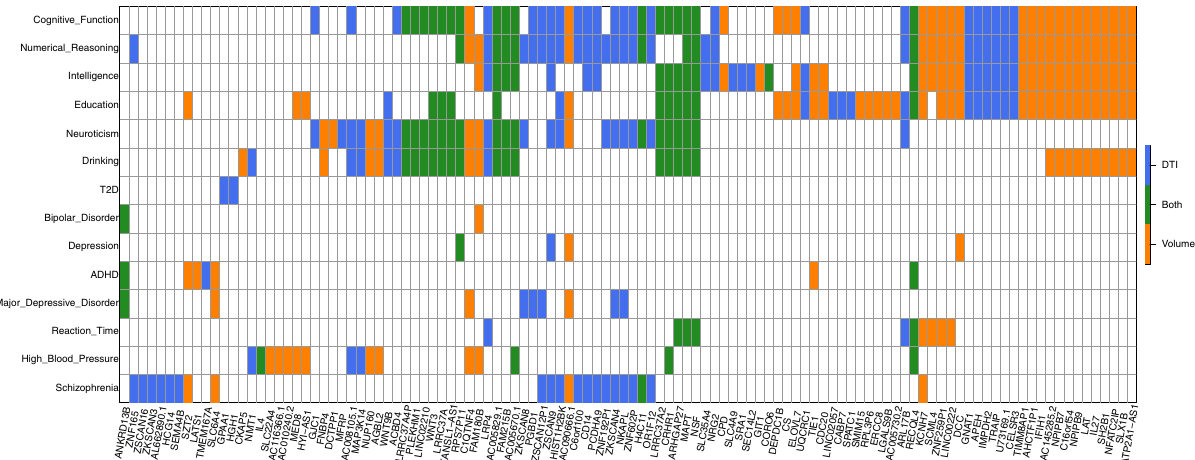
Fig. 3 Overlapping cross-tissue TWAS-signi fi cant genes between neuroimaging traits ( n = 19,629 subjects for ROI volumes and 17,706 for DTI parameters) and other complex traits and clinical outcomes. The gene-level associations were estimated and tested by the cross-tissue UTMOST approach (https://github.com/Joker-Jerome/UTMOST). We adjusted for testing 211 neuroimaging traits ( p value threshold 1.04 × 10 − 8 ) and 16 other traits ( p value threshold 1.37 × 10 − 7 ) with the Bonferroni correction, respectively. The x axis provides the IDs of the neuroimaging traits. The y axis lists the 16 other traits, and Supplementary Data 15 details the resources of their GWAS summary statistics and the sample sizes of corresponding data sets after Bonferroni correction (that is, 101 × 4 + 3 × 110 =